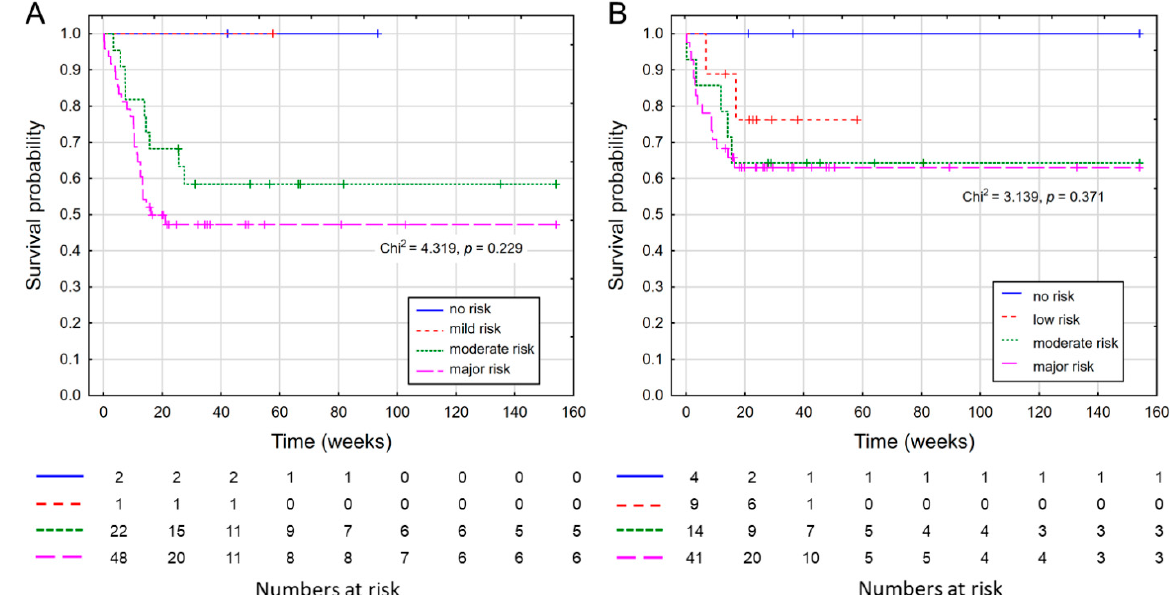
Figure 3. Survival curves ( A ) according to NRI; ( B ) according to GNRI.